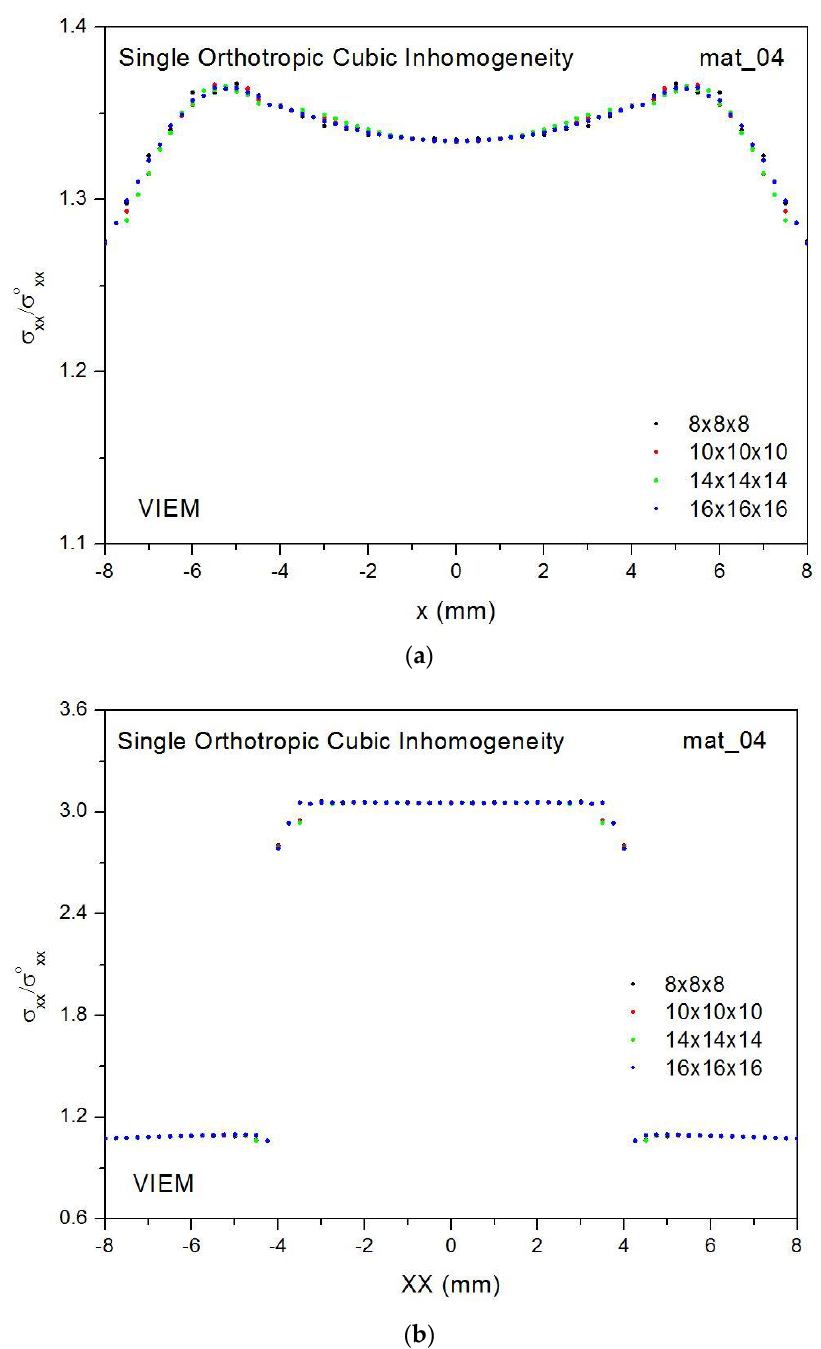
Figure 12. Numerical results using the volume integral equation method (VIEM) for the normalized tensile stress component (σ xx /σ oxx ) along the x-axis and the XX-axis (−8 mm ≤ x, XX ≤ 8 mm) for Model_8 × 8 × 8, Model_10 × 10 × 10, Model_14 × 14 × 14 and Model_16 × 16 × 16 under uniform remote tensile loading. ( a ) x-axis; ( b ) XX-axis.